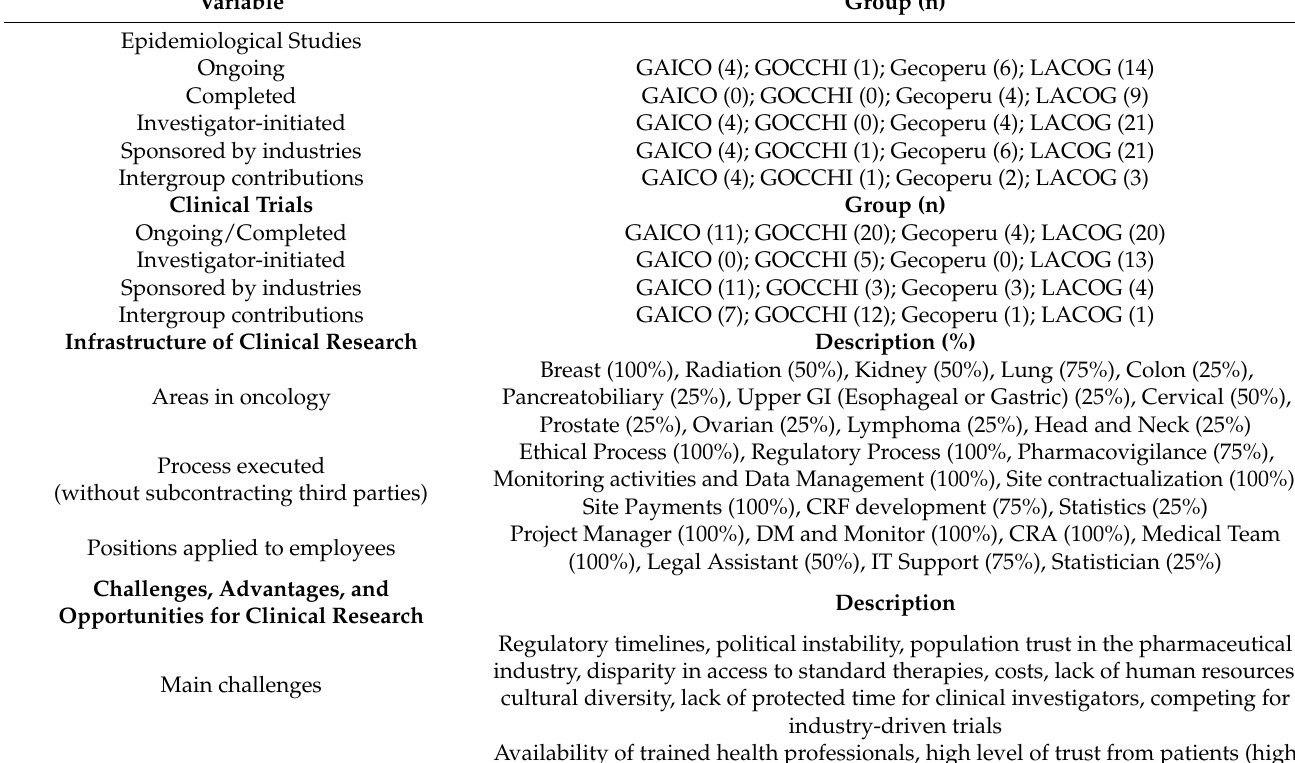
Table 2. Studies conducted by the main academic cancer research groups in Latin America and their infrastructure and considerations about challenges, advantages, and opportunities for clinical research in this